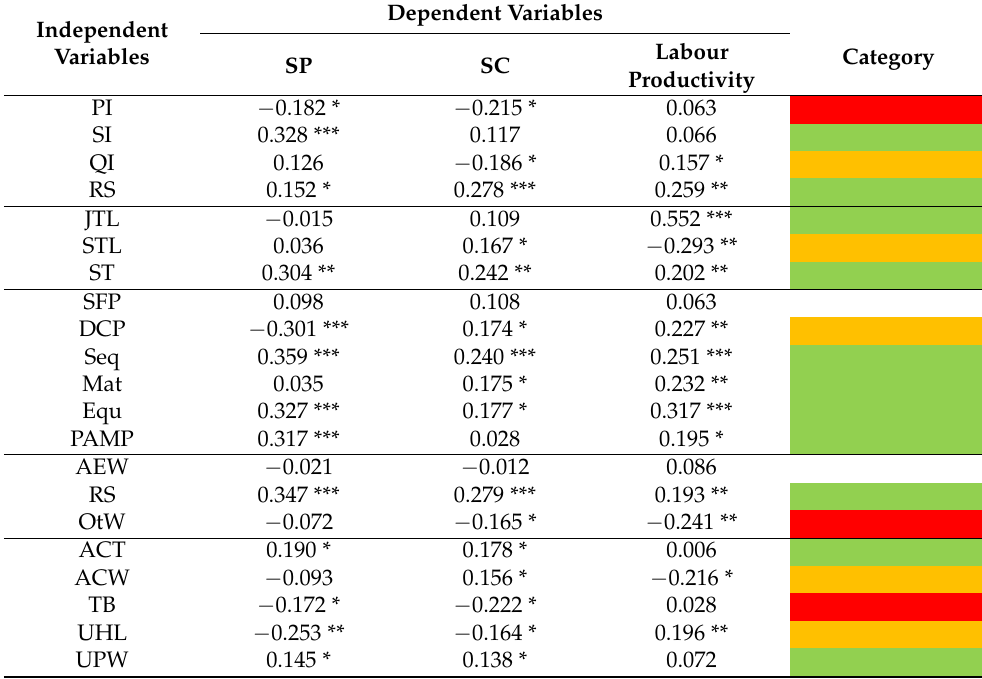
Table 4. MRA models for management